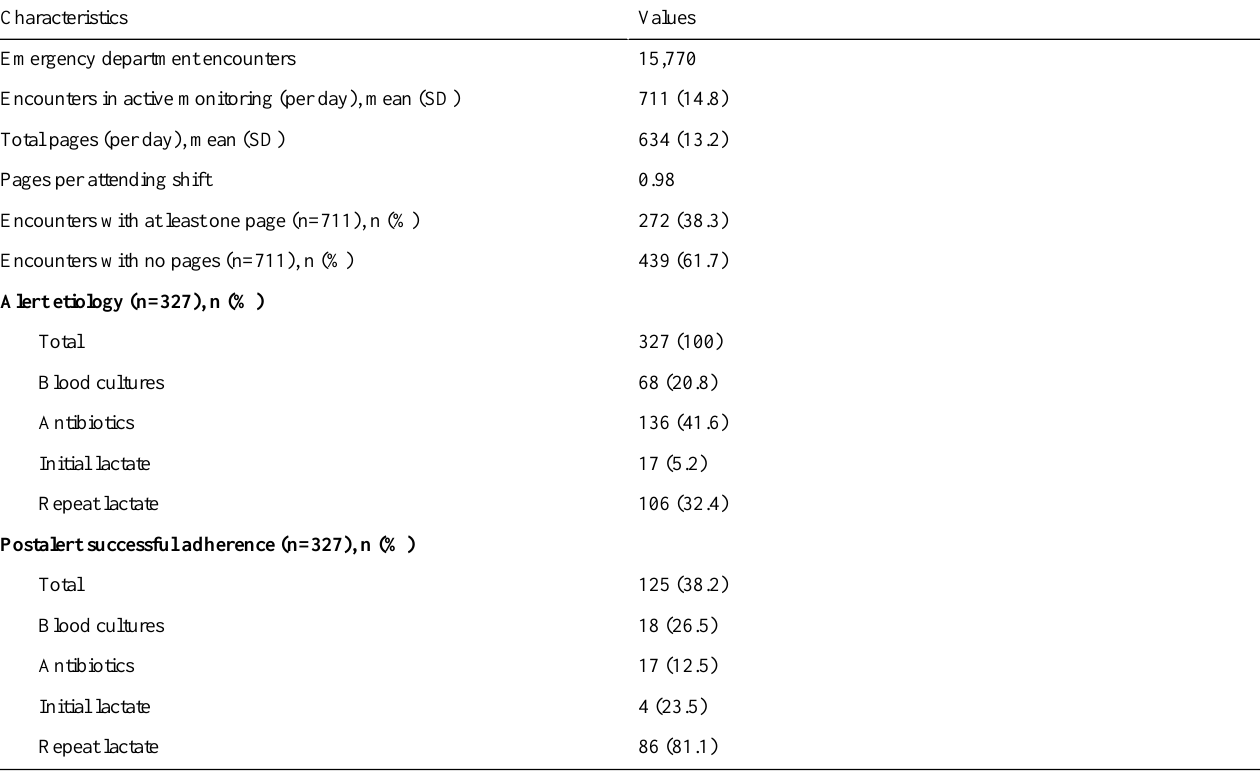
Table 2. Postpilot rollout phase paging and alert data.